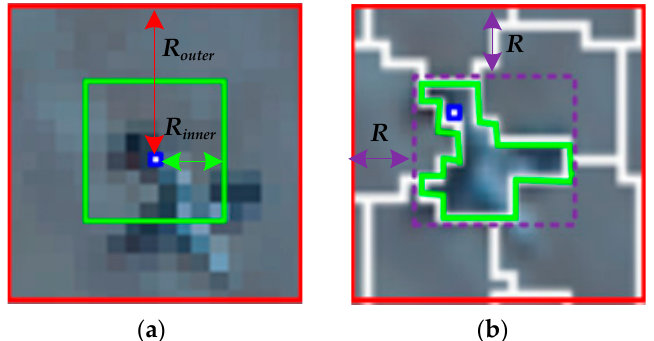
Figure 3. Illustration of dual windows: ( a ) dual rectangular windows; ( b ) adaptive inner window and rectangular outer window.